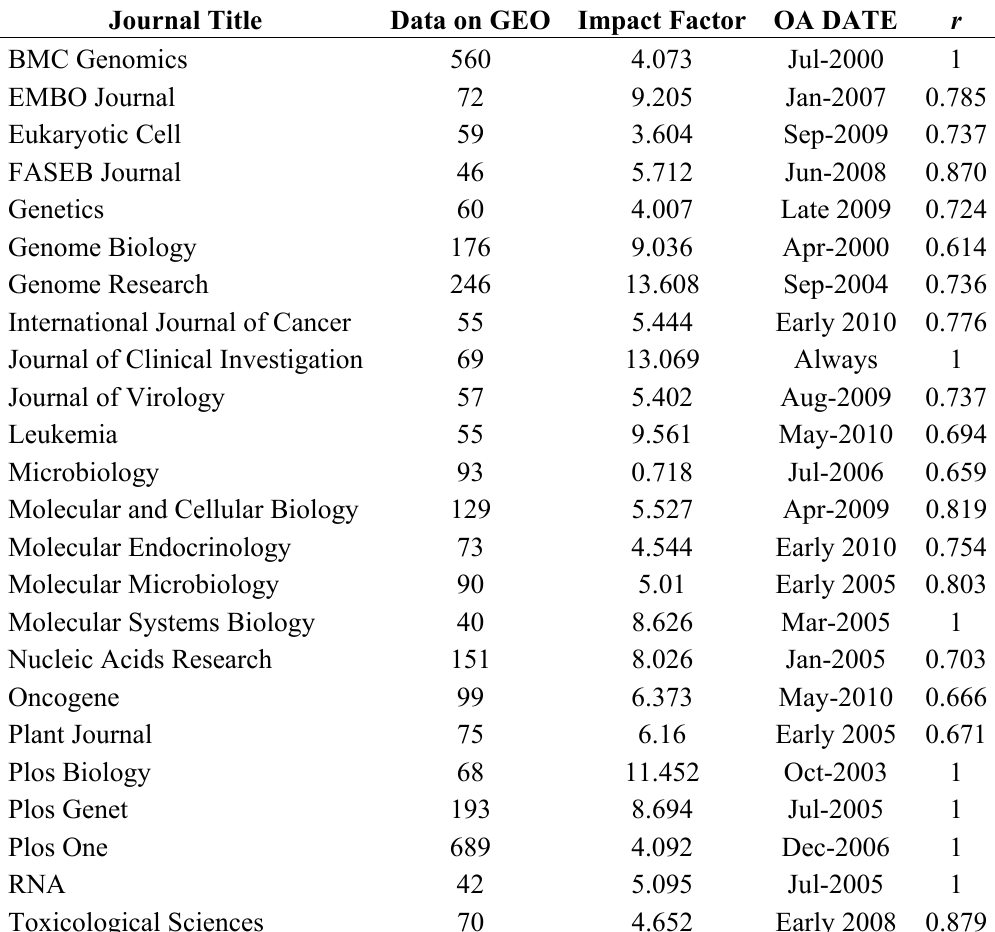
Table 2. Top journals where GEO data contributors published their